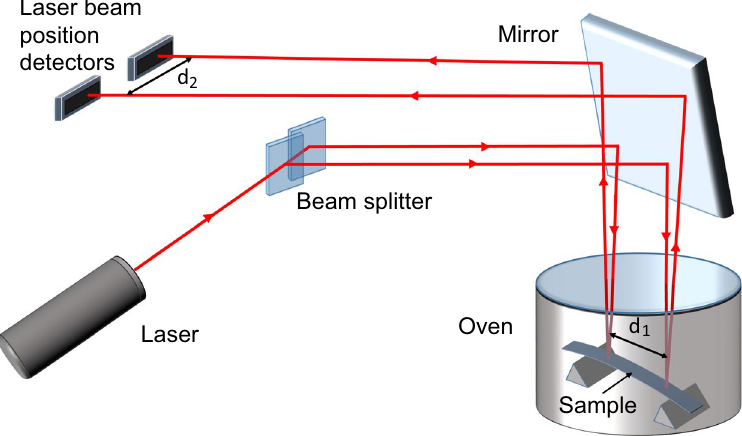
Figure 5. Scheme for the apparatus used in the thermally induced bending technique, to determine the curvature dependence of the film-substrate composite as a function of